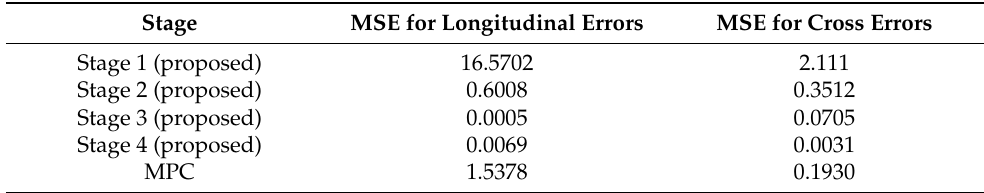
Table 2. Path-following controller performance at different training